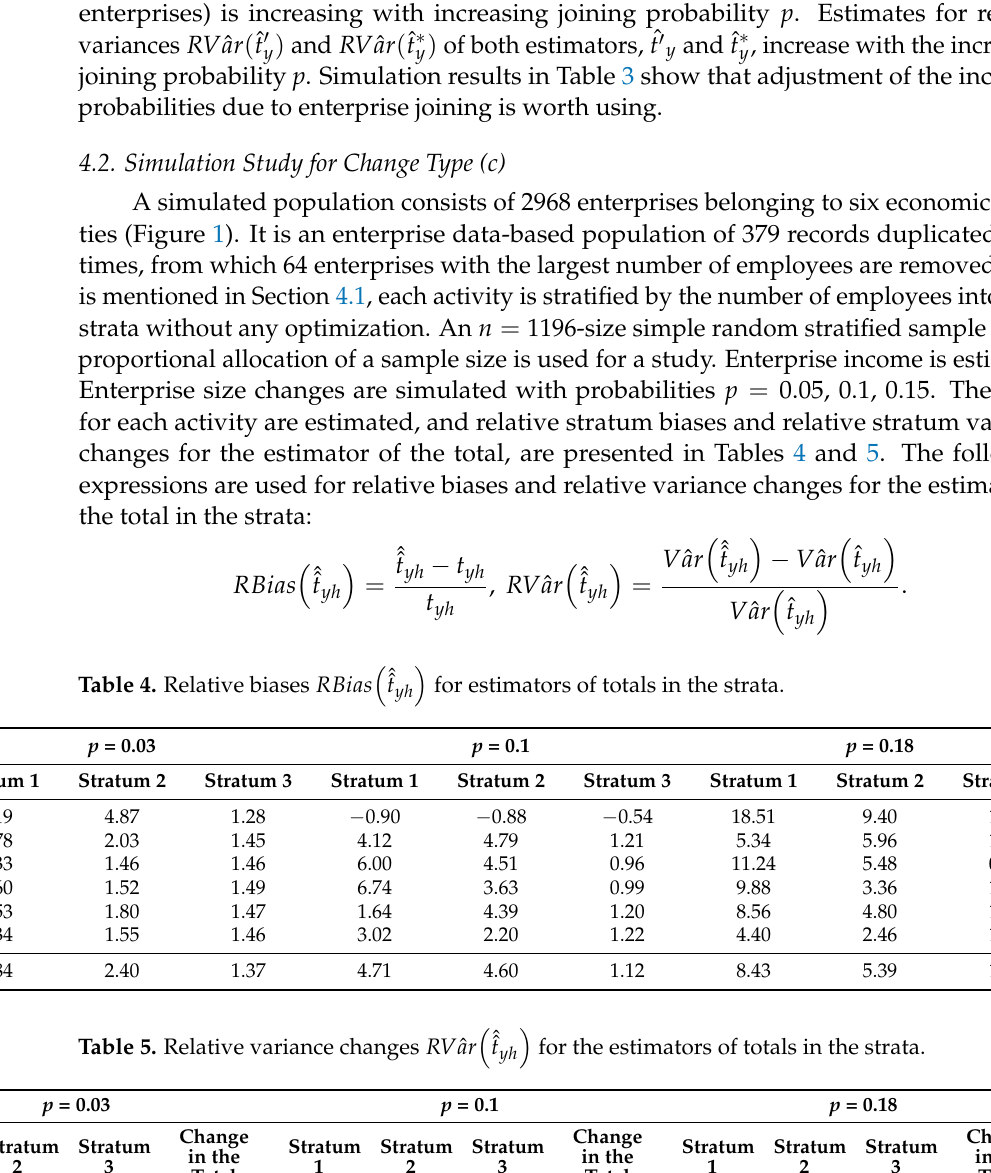
Table 5. Relative variance changes RV ˆ ar p = 0.03 p = 0.1 p =